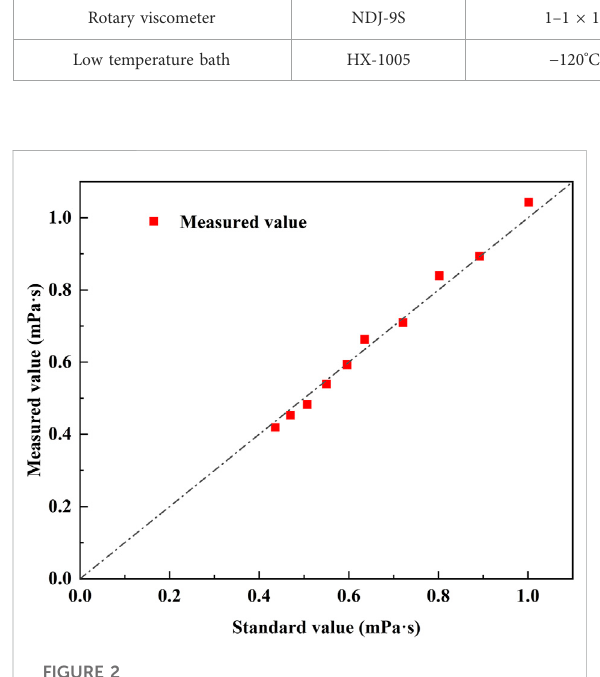
Comparison of measured and standard value of the viscosity of distilled